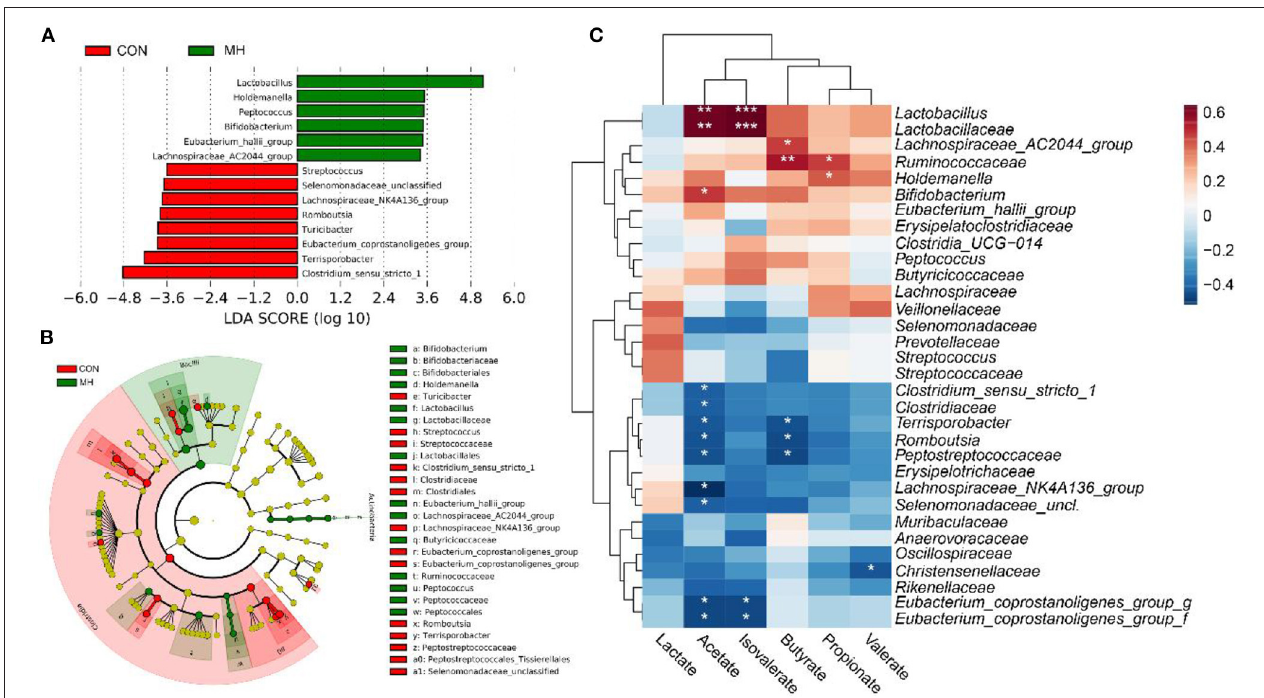
FIGURE 3 | LefSE analysis of gut microbiota and correlation between characteristic bacteria and SCFA of growing pigs between 2 groups. (A) Linear discriminant analysis (LDA) score of the gut microbiota. (B) Cladogram of LEfSe shows taxonomic profiling at the family and genus levels, (C) Correlation between the gut microbiota and SCFA levels. CON = basal diet without any additives, MH = basal diet + 8.3 × 10 9 CFU/kg LM1, n = 12 in the CON group, n = 11 in the MH group. *, **, and *** represented P < 0.05, 0.01, and 0.001, respectively.